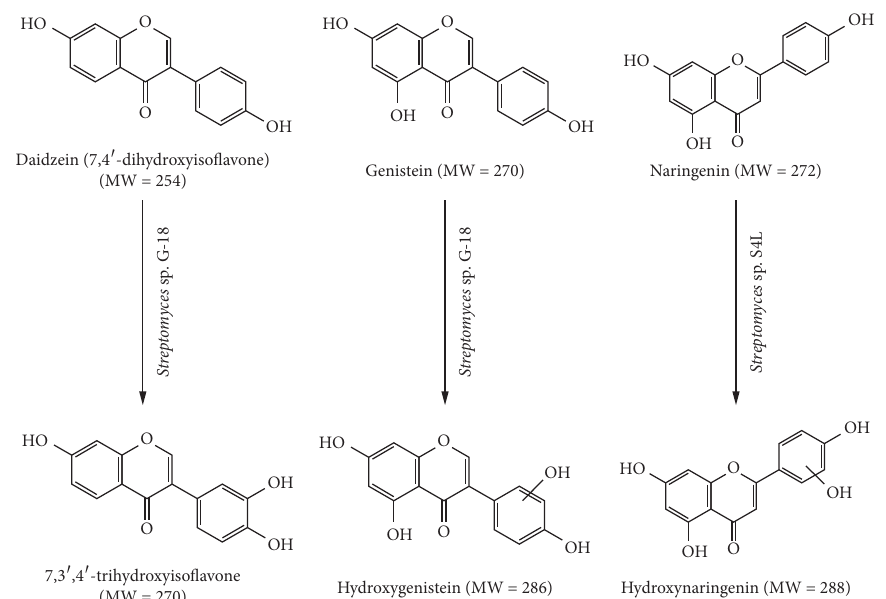
Figure 3: Schematic representation of biotransformation of daidzein, naringenin, and genistein by isolated Streptomyces